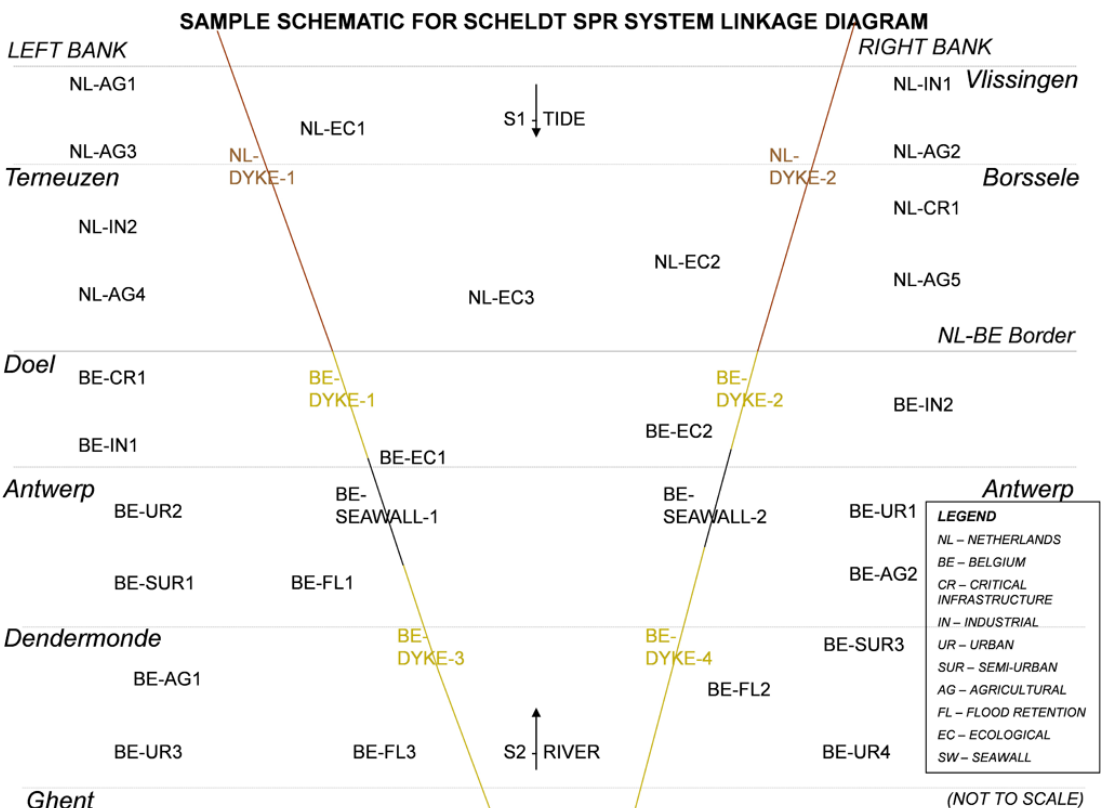
Fig. 2. Simplified stretched schematic of the Western Scheldt showing the considered flood system (100yr flood + 3m, planar water level, no defences), the elements within the flood system including assumed defence sections, political boundaries and the (two) sources of flooding (based on data from Google Earth) (based on steps 1 and 2 of Methodology in Sect.